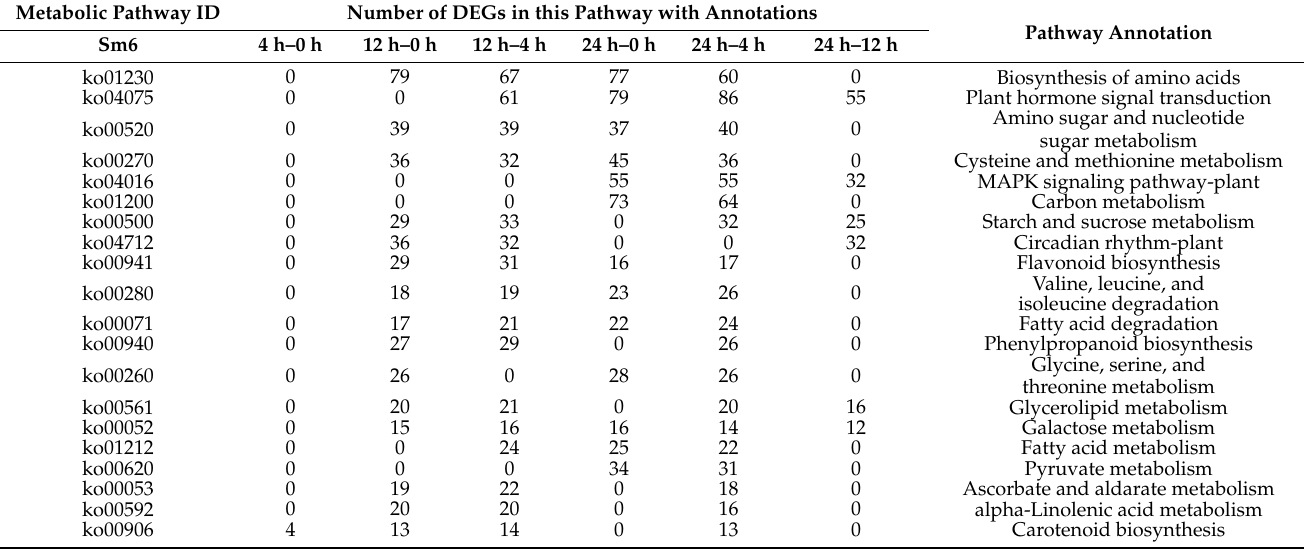
Table 9. The top 20 KEGG pathways with the highest concentration of